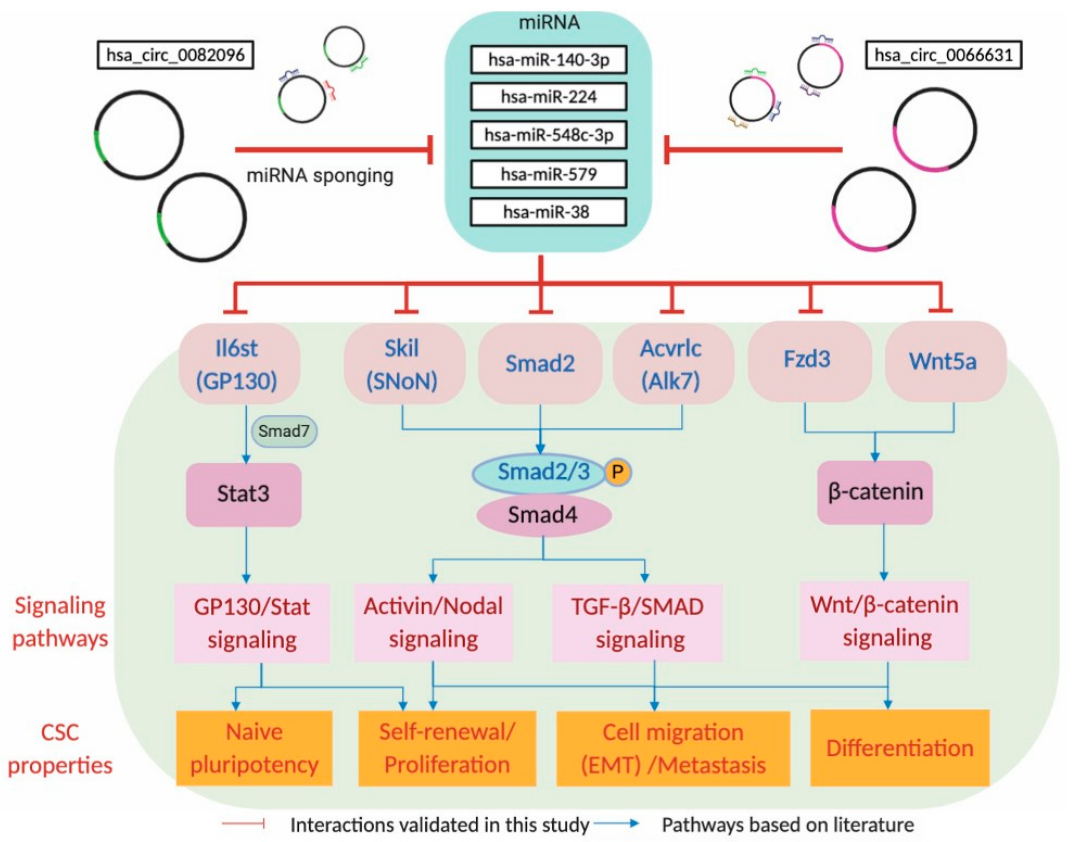
Figure 6. Circ_0082096 and circ_0066631 target signaling pathways that modulate known CSC properties. In the top part of the scheme, the two circRNAs are shown to sponge the five miRNAs, which in turn, modulate the respective signaling pathways (shown in pink boxes) via the gene products of the predicted miRNA-targeted transcripts (shown in red letters), subsequently resulting in the modulation of known CSC properties (orange boxes). See Discussion section for further description of the scheme.